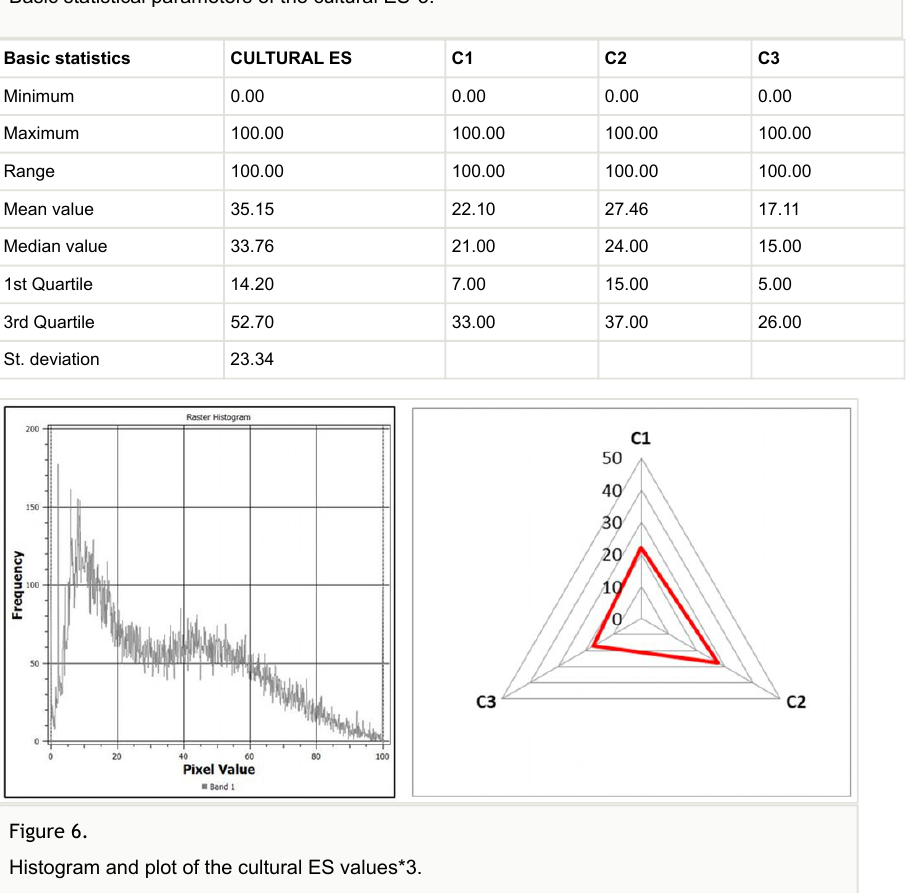
Figure 6. Histogram and plot of the cultural ES